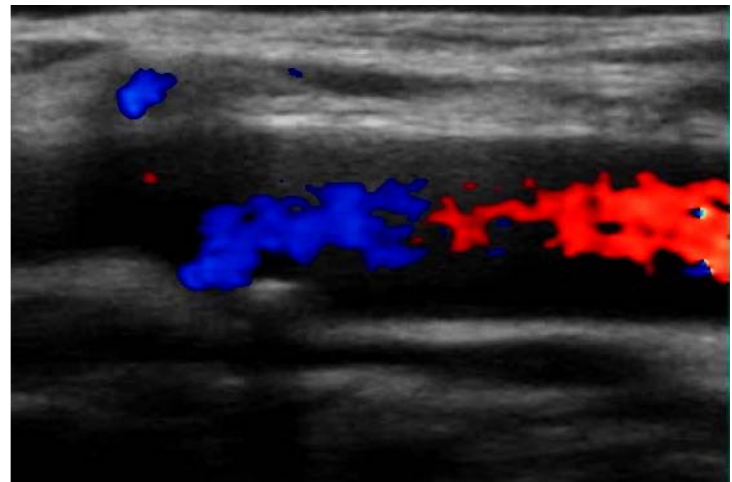
Figure 1. Doppler of the left carotid artery. The image highlights a carotid plaque with consequent flow obstruction (<50%).